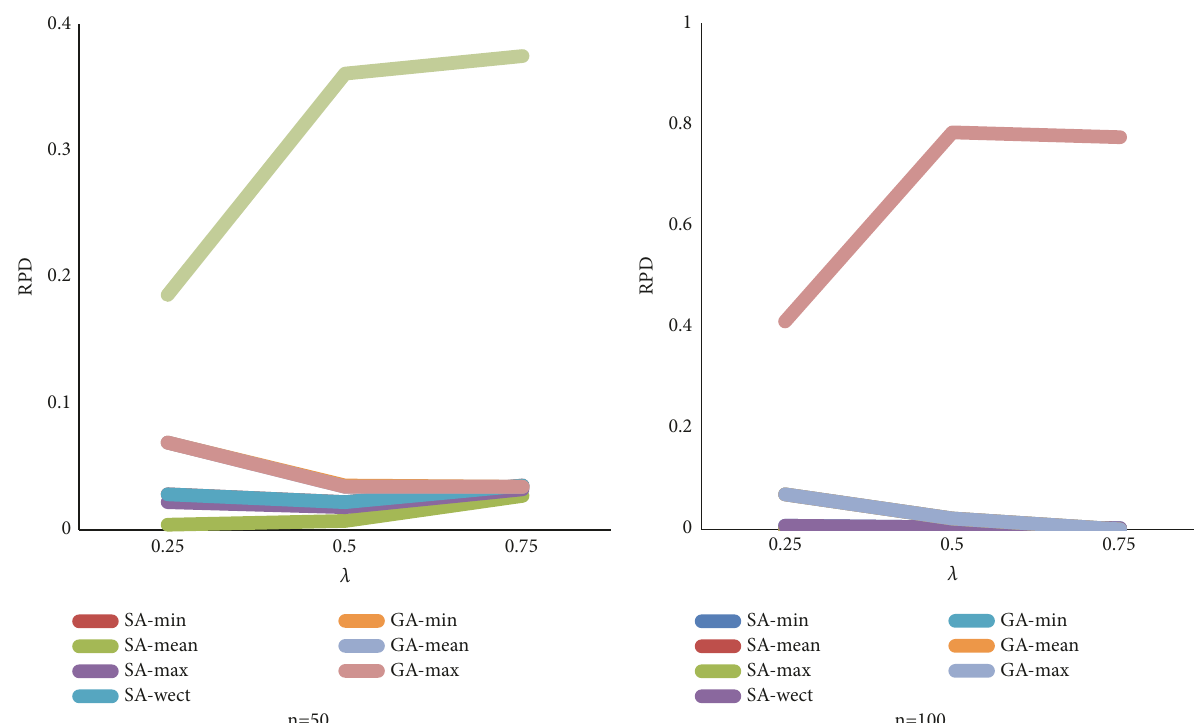
Figure 2: Change of RPD for each 𝑛 as 𝜆 increases for SAs and GAs for large number of orders.